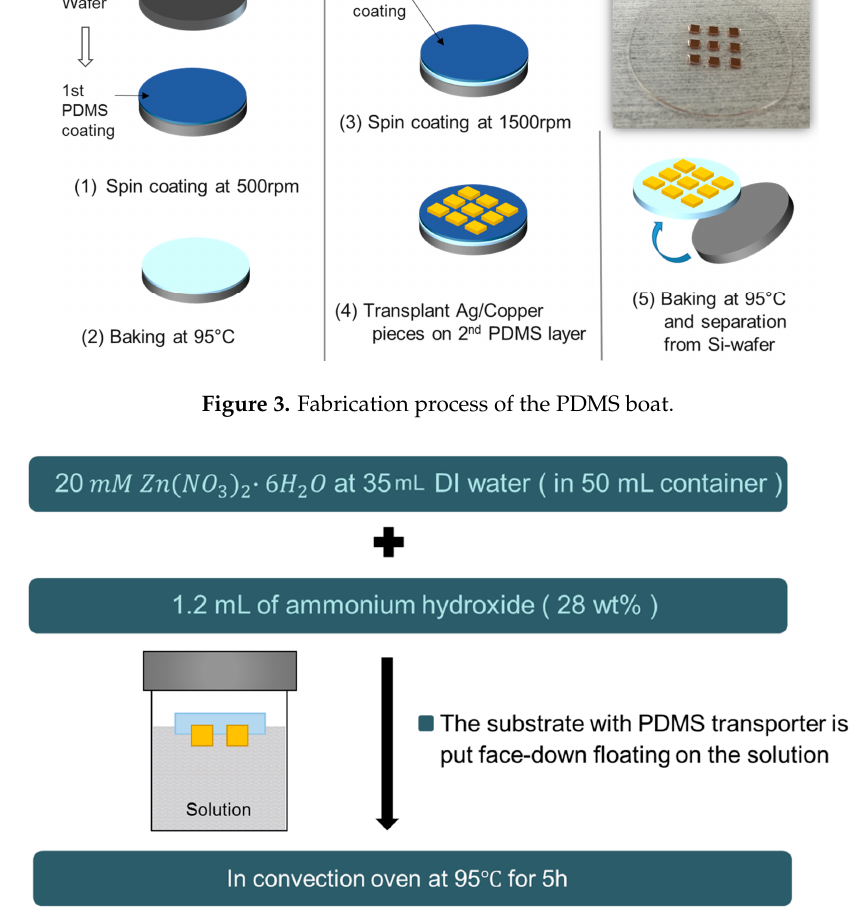
Figure 4. Reaction process of the hydrothermal synthesis of ZnO NW.